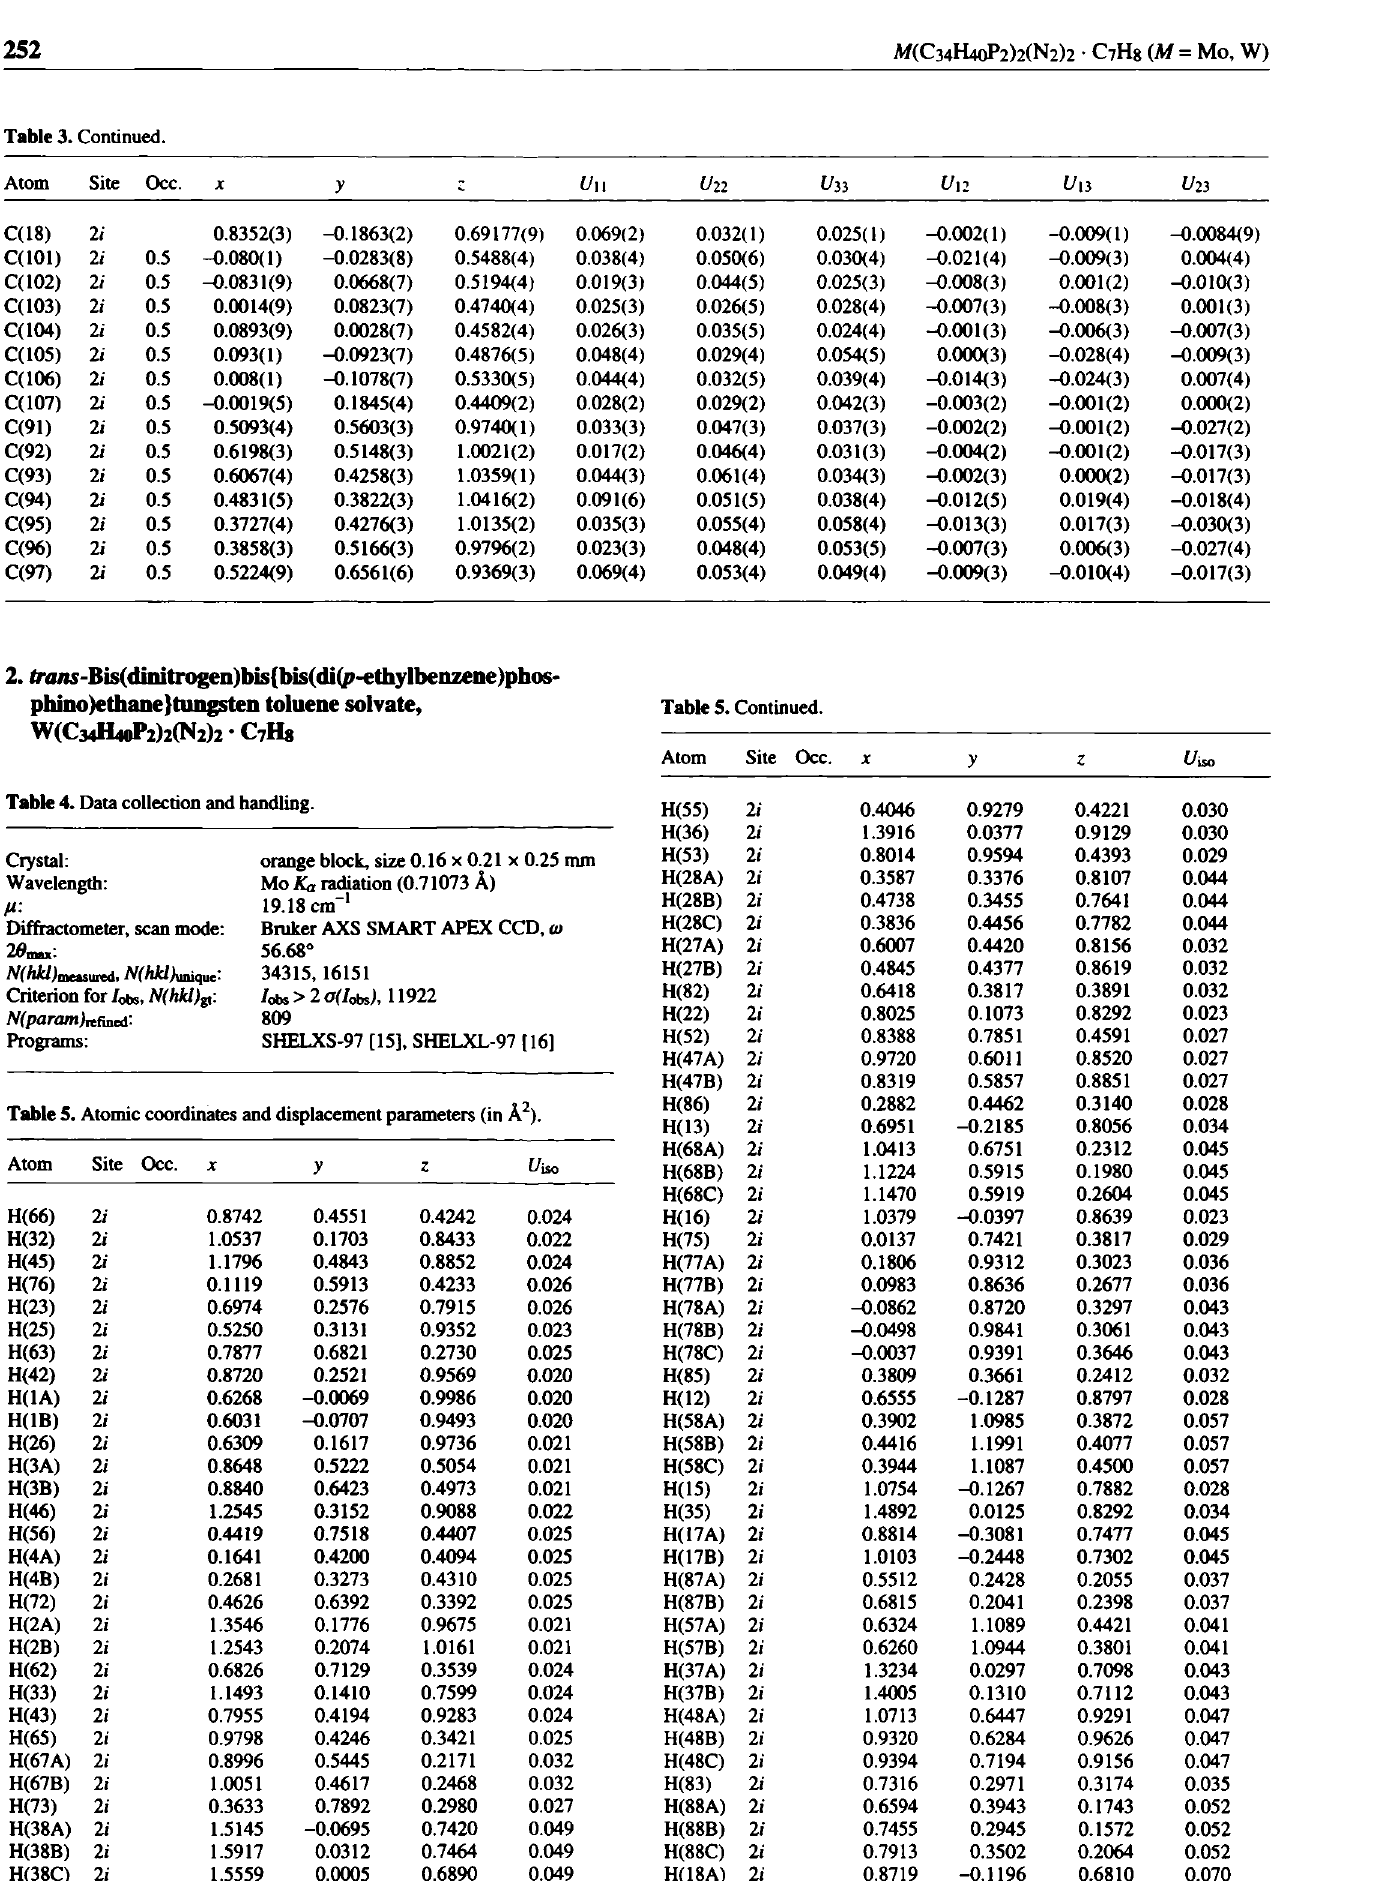
Table 5. Atomic coordinates and displacement parameters (in A 2